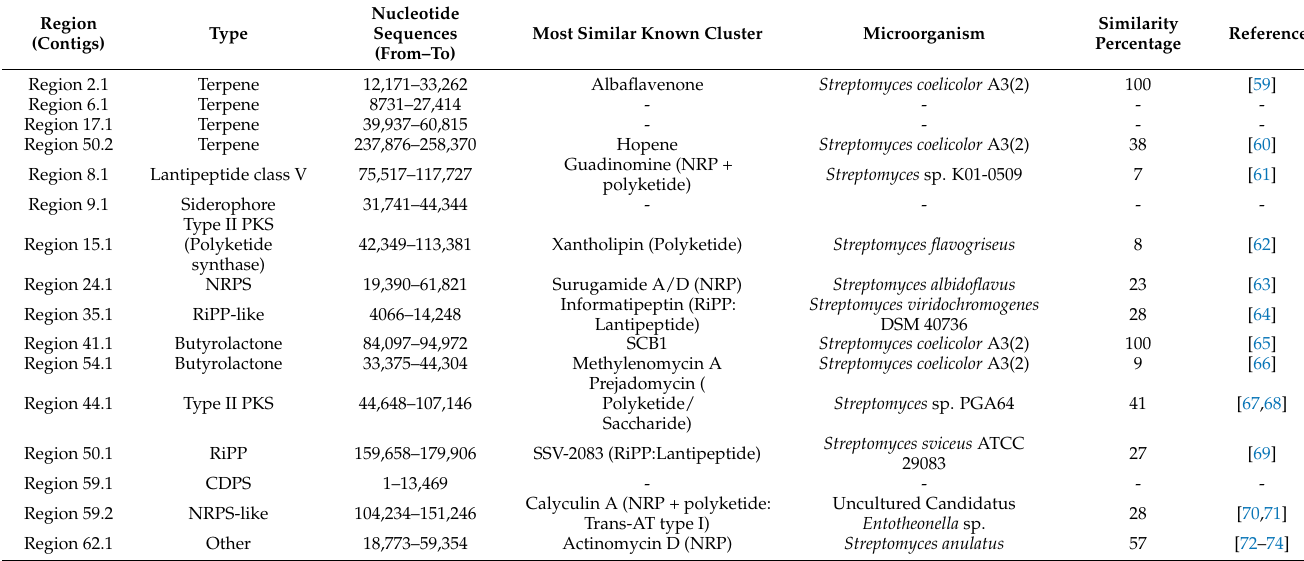
Table 3. Possible secondary metabolites of S. thinghirensis strain HM3 based on genome analysis by